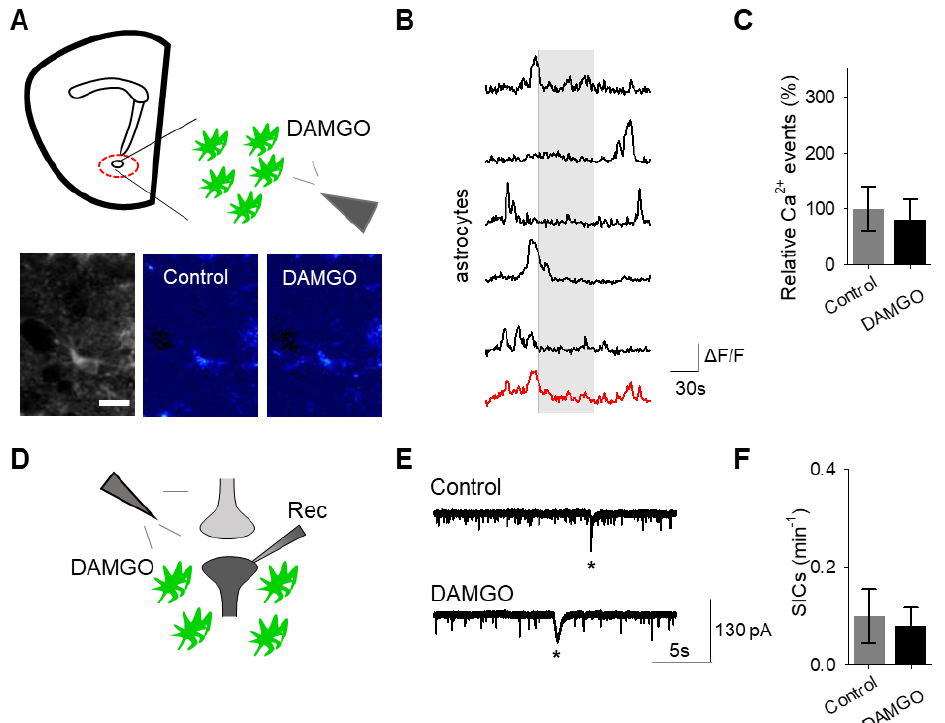
Figure 3. The opioid receptor antagonist naltrexone attenuates DAMGO actions on astrocytes and neurons. ( A ) Scheme of experimental approach and pseudocolor images showing the fluorescence intensities of GCaMP6-expressing astrocytes in the nucleus accumbens, before and after DAMGO application in the presence of naltrexone (10 µM). ( B ) Calcium traces of astrocytes (gray shading indicates DAMGO application; red trace = average) in the presence of naltrexone. ( C ) Relative calcium events before (control) and after DAMGO application in the presence of naltrexone. ( D ) Scheme of electrophysiology experimental approach in the nucleus accumbens. ( E ) Representative electrophysiology recordings in control conditions and after DAMGO application in the presence of naltrexone. ( F ) SICs per minute before (control) and after DAMGO application in the presence of naltrexone. Data are expressed as mean ± SEM, scale bar = 10 µm.